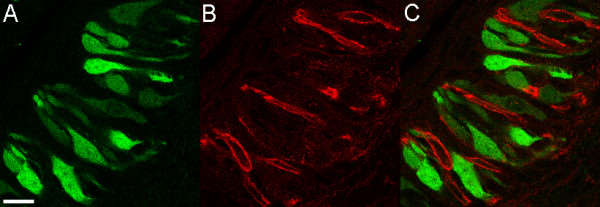
LCSMs from mouse circumvallate papillae showing T1R3 promoter driven GFP expression and SNAP-25-LIR. Green denotes GFP expression (A, C) and red SNAP-25-LIR (B, C). The GFP+ cells appear to be a separate population than those with SNAP-25-LIR. Scale bar is 20 μm.